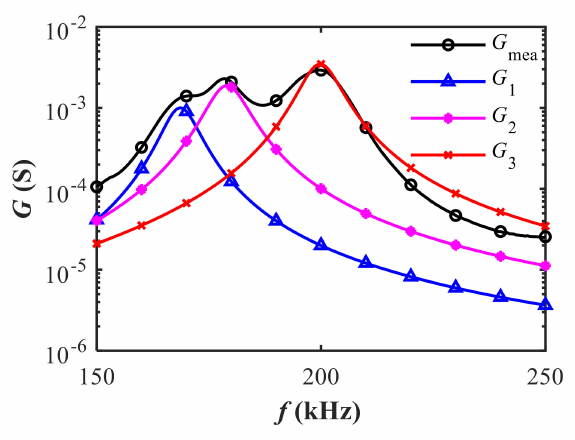
Figure 7. The measured conductance and the calculated conductance of three individual resonances based on the estimated